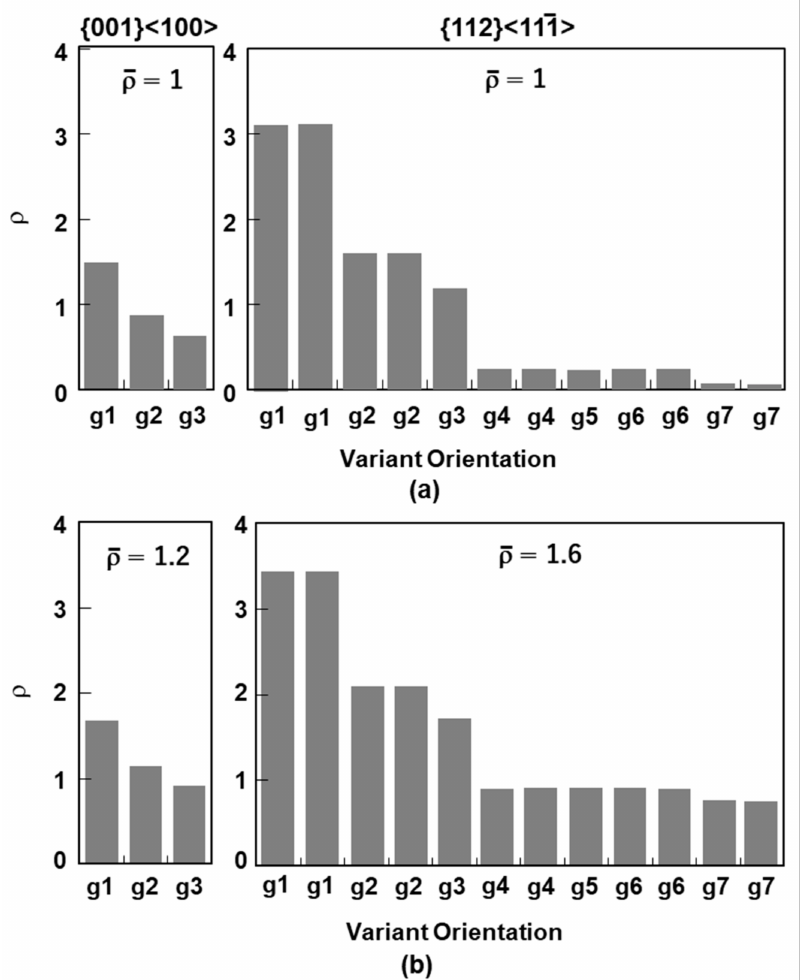
Figure 10. Variant selection probability, ρ , for parent orientations {001}<100> and {112}<111> in the optimum prediction by ( a ) DBOR and ( b ) EDBOR n = 1 for β → α -hex transformation in Figure 9b,c,e–h. The conditions for optimum prediction are indicated by ( a ) arrow b and ( b ) arrow c in Figure 8. See Table 2 for variant